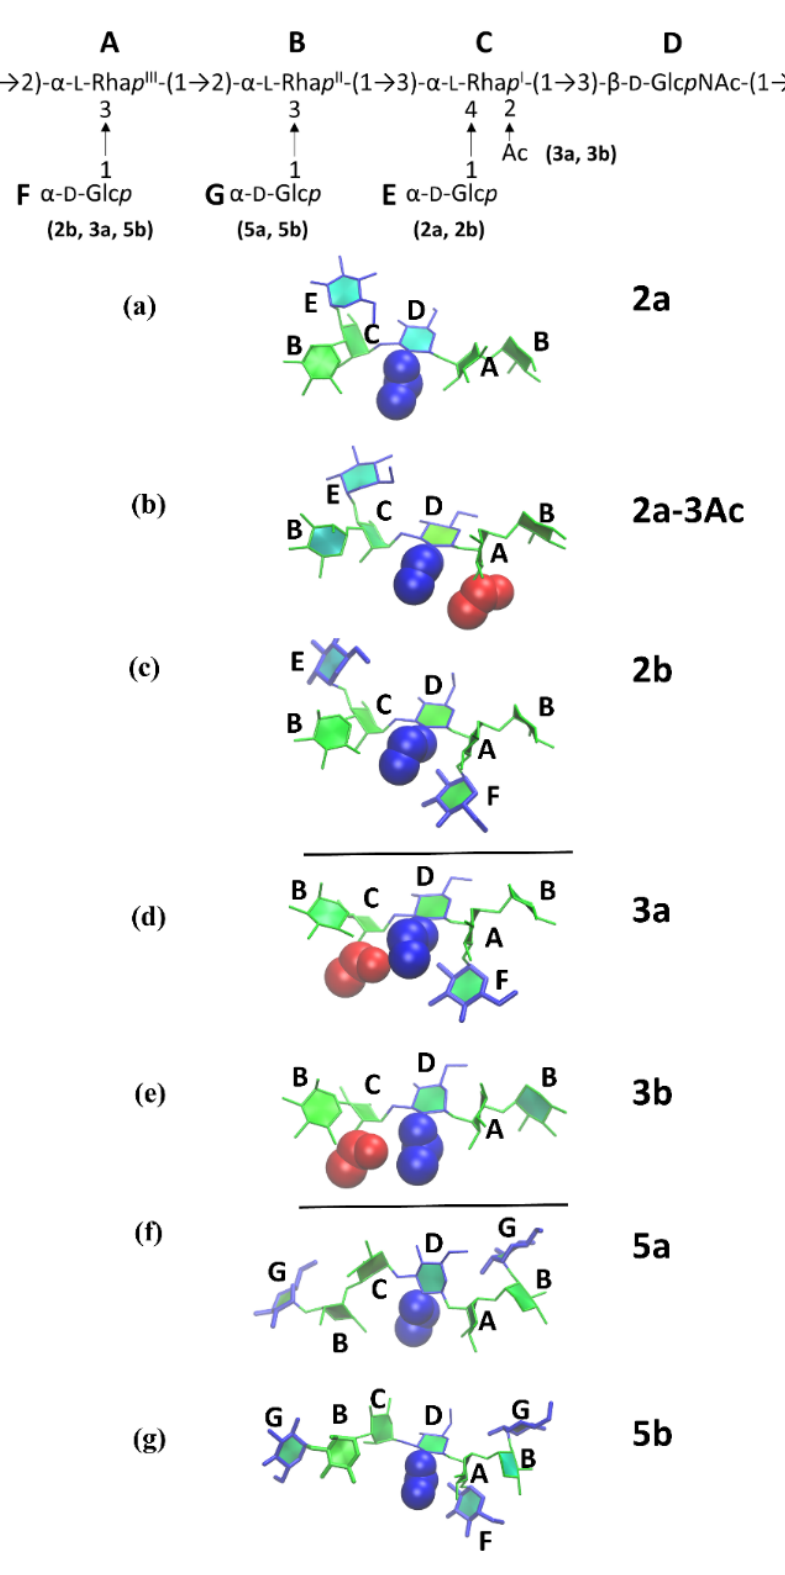
Figure 5. Fragments of the backbone showing the relative arrangements of the sidechains, the N-acetyl (blue) and the O-acetyl (red) substituents for serotypes ( a ) 2a, ( b ) 2a-3Ac, ( c ) 2b, ( d ) 3a, ( e ) 3b, ( f ) 5a, and ( g ) 5b. Glucose rings are colored blue, rhamnose green.